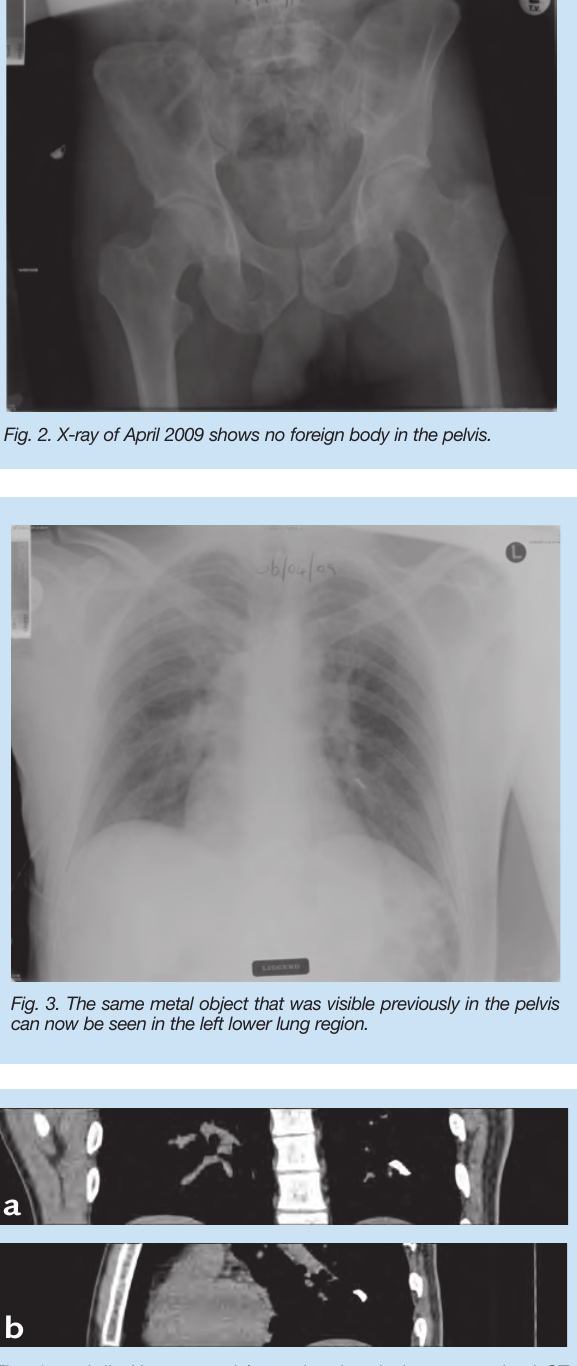
Figs 4a and 4b. Uncontrasted (coronal and sagittal reconstructions) CT scans of the chest demonstrate the metal foreign object in a pulmonary artery branch to the left lower